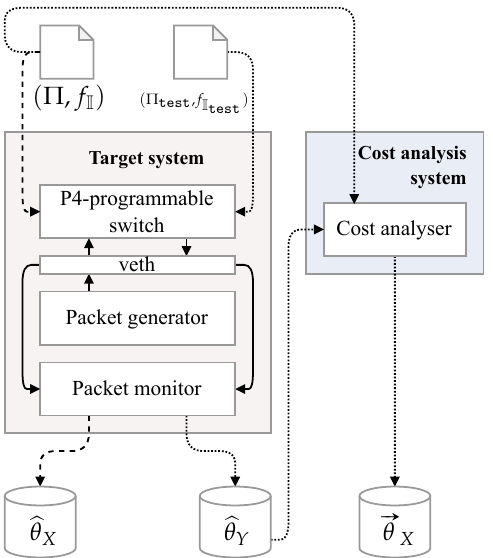
Figure 4. System set-up for validating estimates resulting from static cost